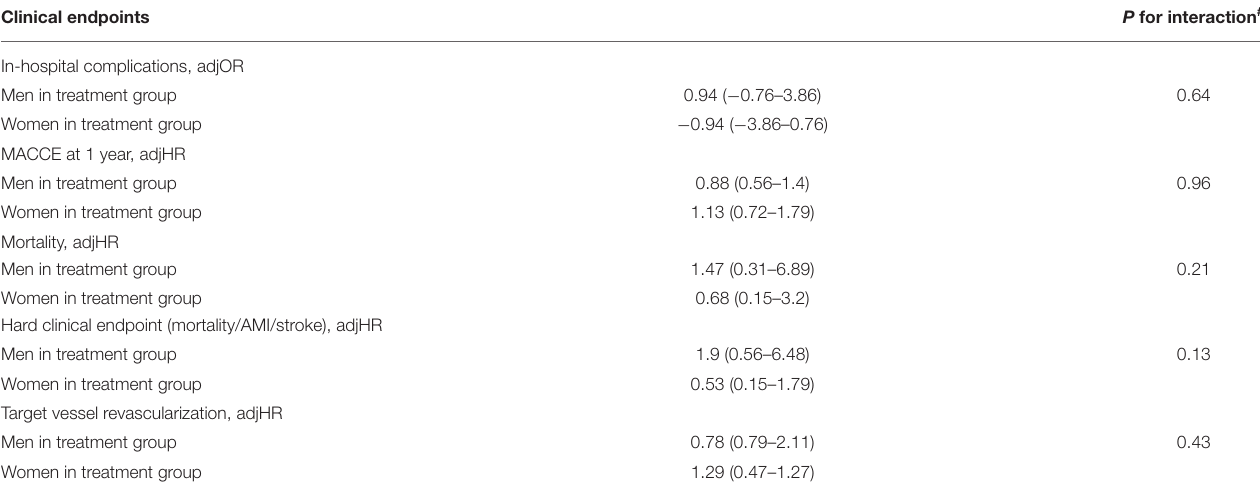
TABLE 4 | Clinical safety outcome results in cell therapy groups stratified by sex.